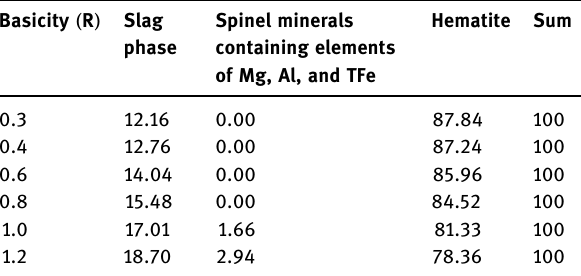
Table 6: Equilibrium mineralogical composition of briquettes with di ff erent basicity and CaO content ( wt%; 1,250°C ) Basicity ( R ) Slag